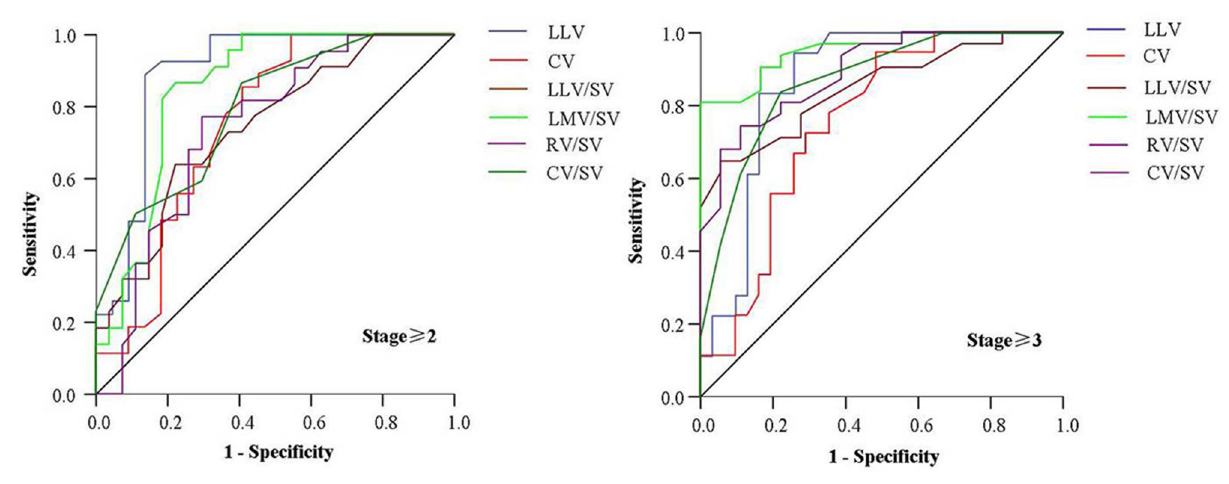
Figure 4. Receiver operating characteristic curves of liver lobe volume parameters for classifying liver fibrosis stage ≥2 and ≥3. The figure shows left lateral liver lobe volume (LLV), caudate lobe volume (CV) as well as the ratios of LLV to spleen volume (LLV/SV), left medial liver lobe volume to spleen volume (LMV/SV), right liver lobe volume to spleen volume (RV/SV), and caudate lobe volume to spleen volume (CV/SV) for classifying liver fibrosis stage ≥2 and ≥3.